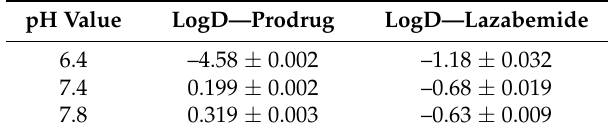
Table 1. The logD values of the L -dopa–lazabemide prodrug and lazabemide at different pH values.